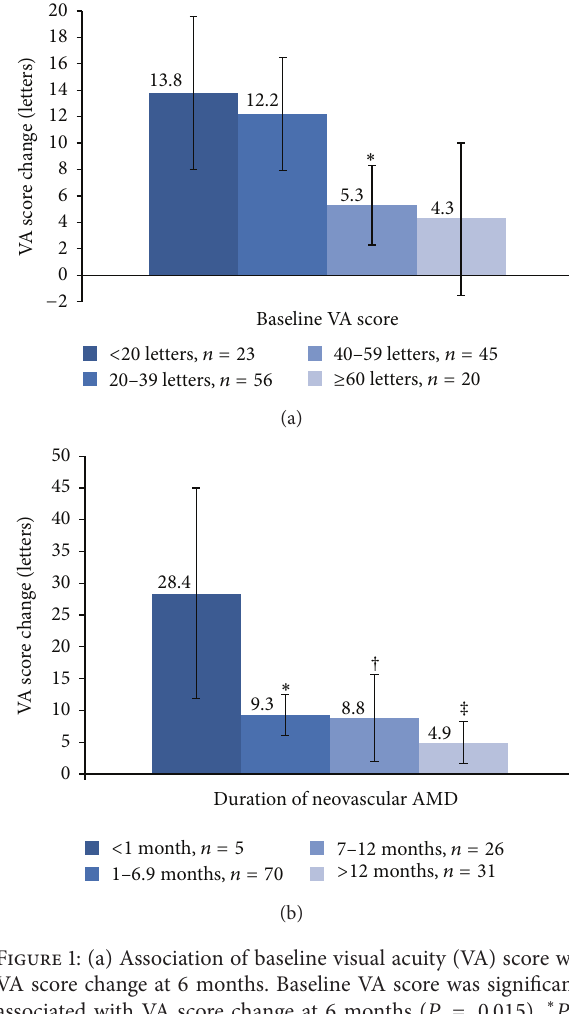
Figure 1: (a) Association of baseline visual acuity (VA) score with VA score change at 6 months. Baseline VA score was significantly associated with VA score change at 6 months ( 𝑃 = 0.015 ). ∗ 𝑃 = 0.036 (the first group was the reference). (b) Association of duration of neovascular age-related macular degeneration (AMD) with VA score change at 6 months. Duration of neovascular AMD was significantly associated with VA score change at 6 months ( 𝑃 = 0.005 ). ∗ 𝑃 = 0.005 ; † 𝑃 = 0.007 ; ‡ 𝑃 = 0.001 (the first group was the